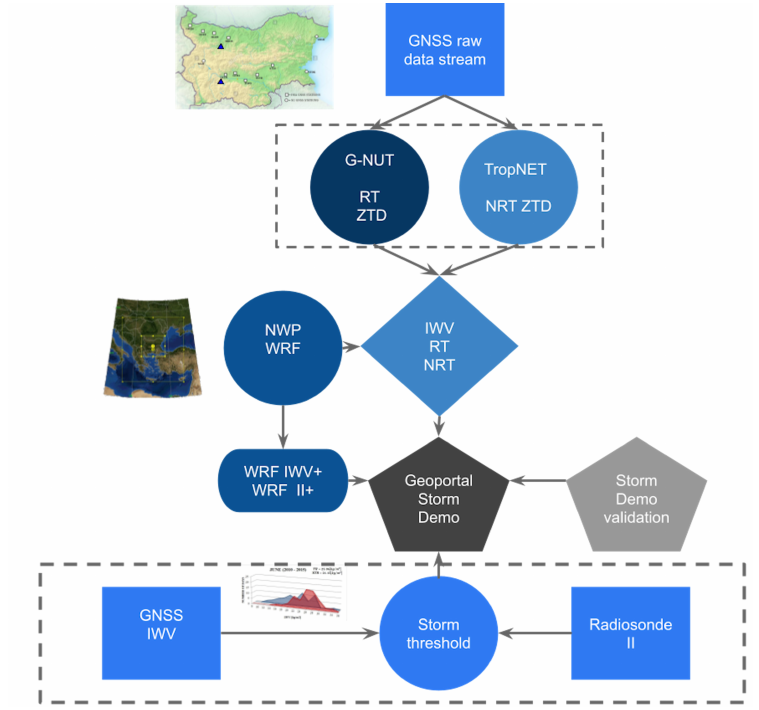
Figure 1. Storm Demo concept